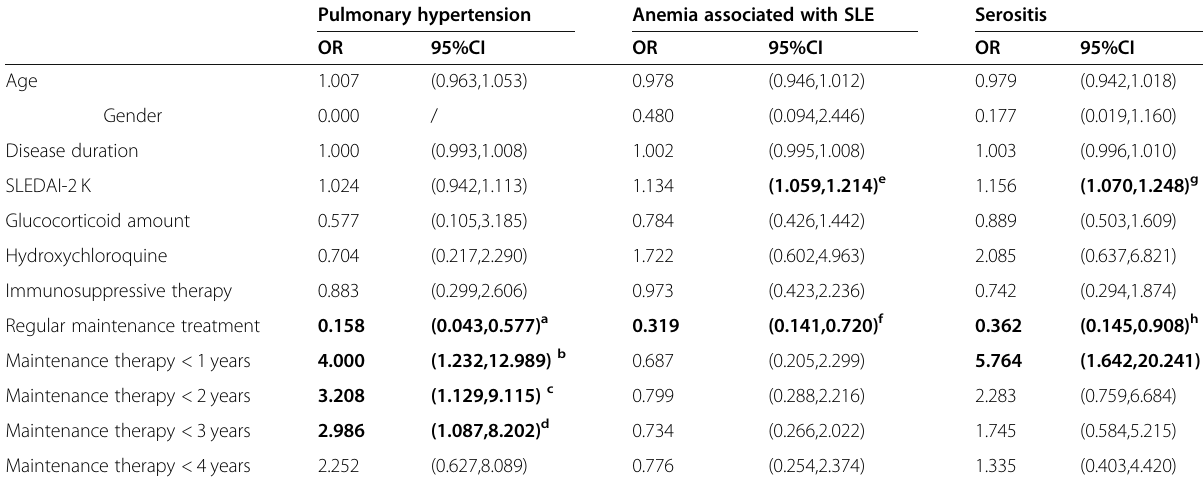
Table 7 Risk factors of pulmonary hypertension, anemia and serositis in SLE flare Pulmonary hypertension Anemia associated with SLE Serositis